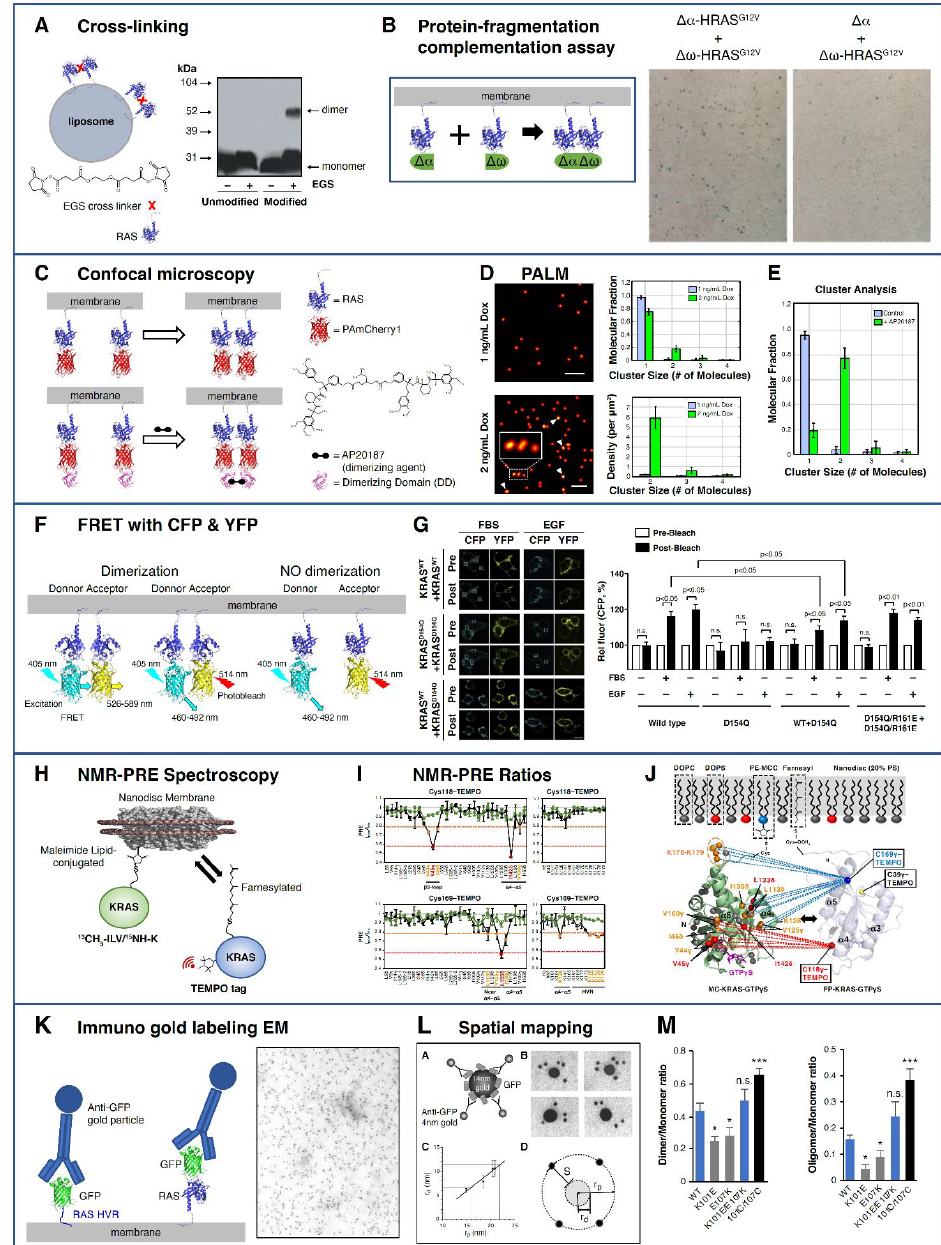
Figure 6. RAS–RAS interaction studies. ( A ) KRAS-FMe proteins, purified from Sf9 cells, are cross-linked with EGS on POPC liposomes, followed by SDS Page and then Western blot with anti-KRAS antibody [52]. ( B ) RAS dimerization detected using protein-fragmentation complementation assay with the weakly complementing deletion β -gal mutants, ∆ α and ∆ ω , fused to the N terminus of HRAS. Only when both ∆ α and ∆ ω are brought together by HRAS is Xgal activity detected (blue color) [52]. ( C ) Schematics of PAmCherry1-KRAS (top) and artificial dimerization of DD- PAmCherry1-KRAS using a small molecule (AP20187), which binds two dimerization domains (DD) at the same time (bottom) [53]. ( D ) Photoactivated localization microscopy (PALM) images and cluster analysis of PAmCherry1-KRAS G12D in intact cells showing increase dimerization with higher doxycycline-induced expression level. Each dot in the image is a single KRAS, and arrows and bottom inset indicate dimers. Scale bars are 200 nm. ( E ) Cluster analysis of DD-PAmCherry1-KRAS G12D artificially dimerized with AP20187. ( F ) Schematic showing KRAS dimerization and no dimerization using acceptor photobleaching Förster (Fluorescent) resonance energy transfer (FRET) assays with Cyan fluorescent protein (CFP) (donor) and yellow fluorescent protein (YFP) (acceptor)